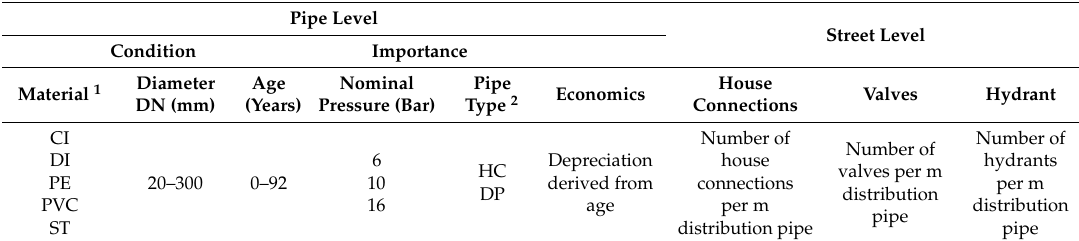
Table 2. Influencing factors for the water distribution